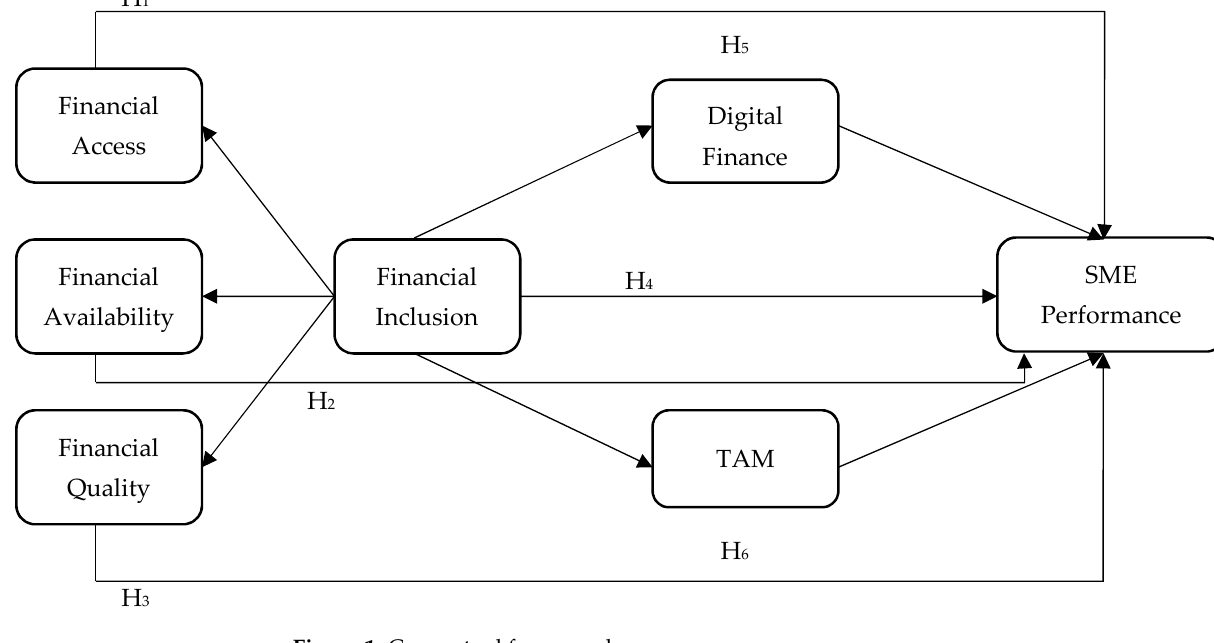
Figure 1. Conceptual